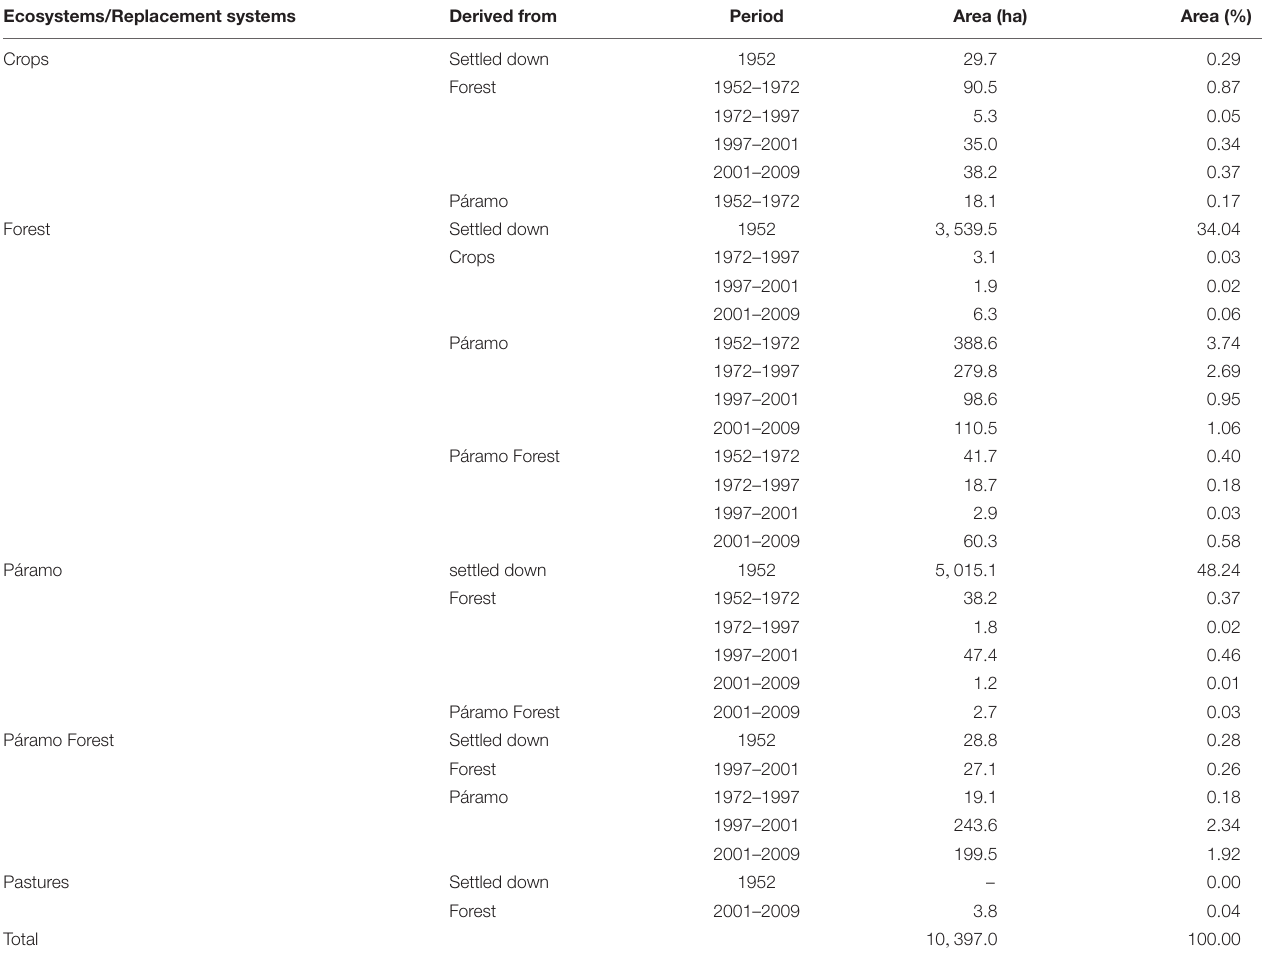
TABLE 1 | Ecosystems transitions at the Capaz area, Cordillera de Mérida. Ecosystems/Replacement systems Derived from Period Area (ha) Area (%) Crops Settled